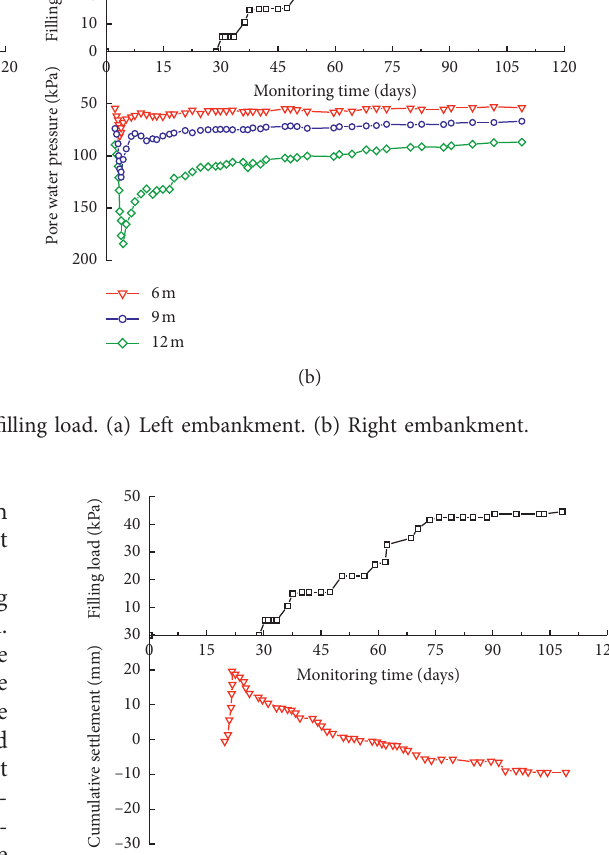
Figure 15: Variation of cumulative settlement with filling